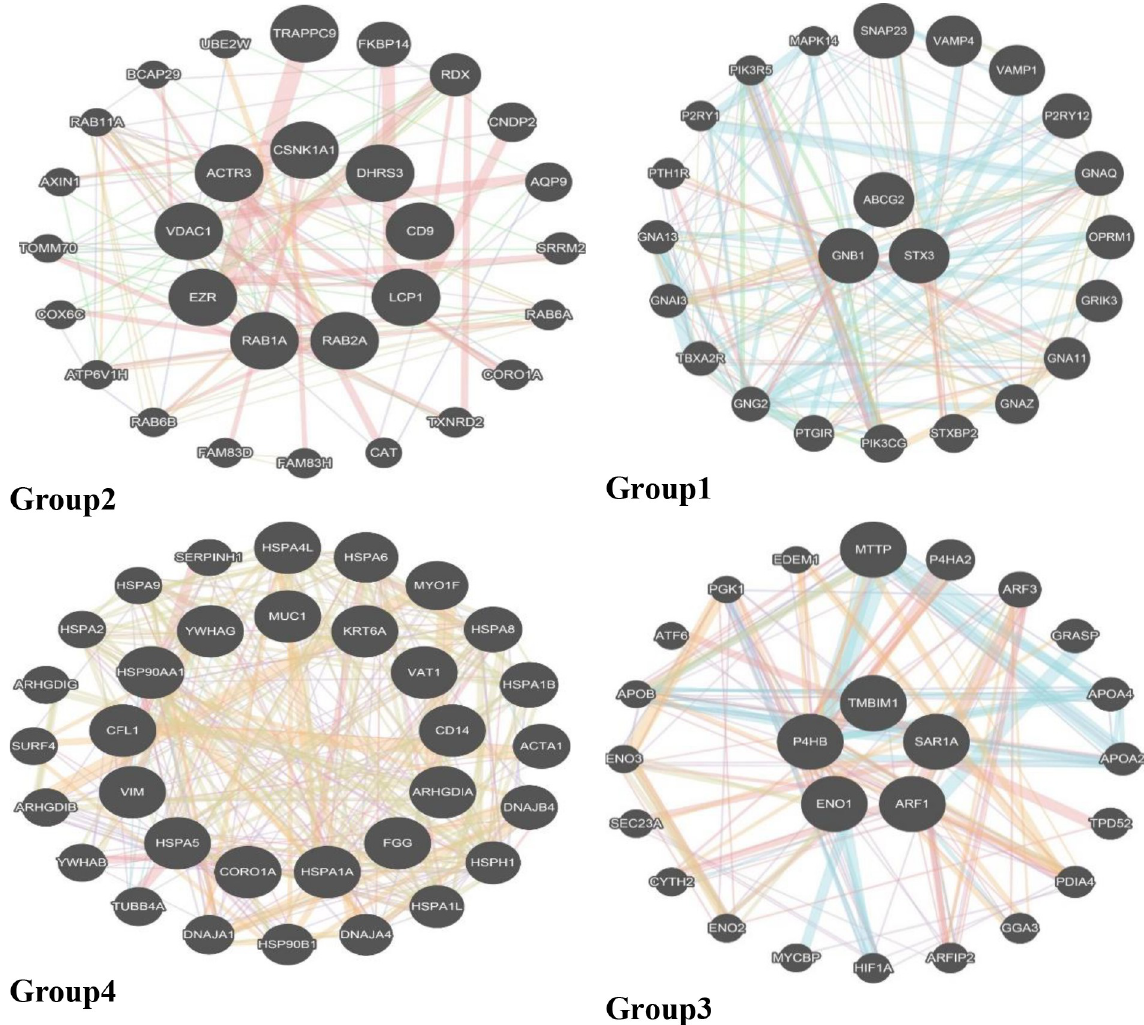
Fig 4. Gene group annotation extraction by GeneMANIA based on DFT based average clustering results.